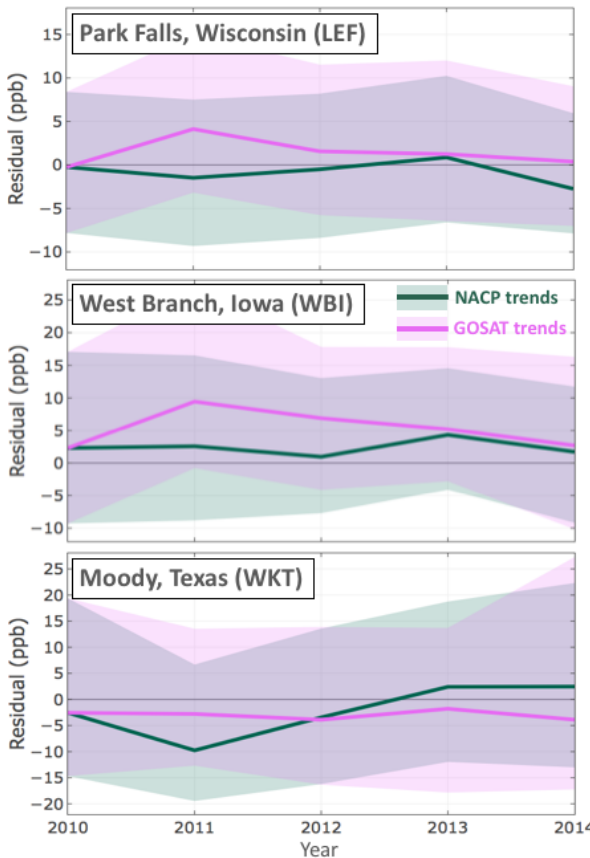
Figure 6. Time series of the residuals (observed minus simulated methane concentrations) of the CarbonTracker-Lagrange (CT-L) CH 4 transport model simulations driven by posterior emissions op- timized for NACP data (green) and scaled to GOSAT-inferred emis- sion trends (purple) for three surface sites particularly sensitive to emissions from different sectors: LEF (45.9 ◦ N, 90.3 ◦ W), WBI (41.7 ◦ N, 91.4 ◦ W), and WKT (31.3 ◦ N, 97.3 ◦ W). Solid lines show the medians of NACP and GOSAT trends, and shaded areas show the 25th–75th percentile